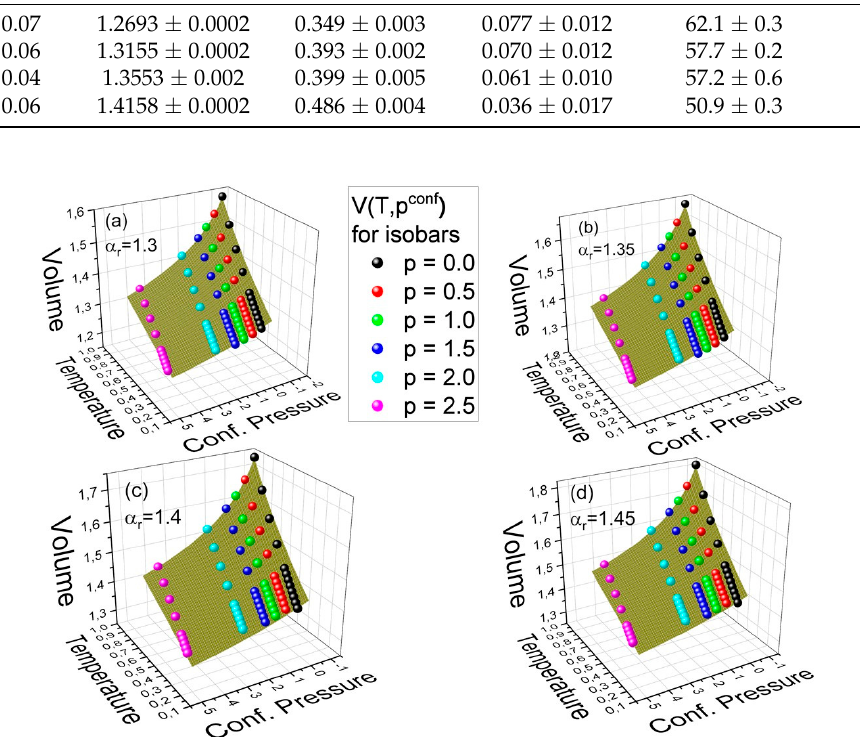
Figure A3. The plots of the dependences of the particle number volume V on temperature T and the configurational pressure p conf in the supercooled liquids states in the GB model. The meshed surfaces represent the fits to the EoS given by Equation (A1) with the value of its parameters collected in Table A1. In the separate panels, there are the cases shown for the different anisotropy aspect ratios α r : ( a ) 1.30, ( b ) 1.35, ( c ) 1.40, and ( d ) 1.45, respectively.